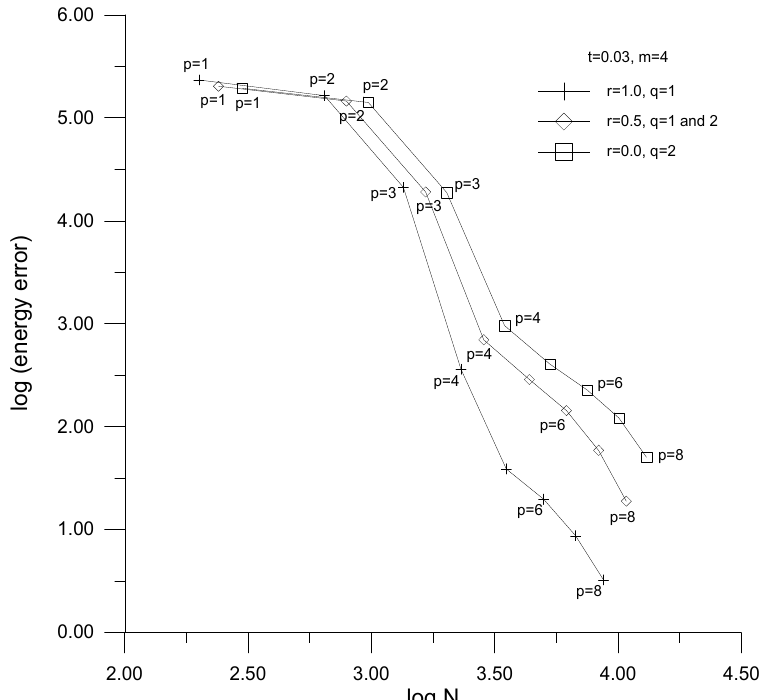
Figure 25. Convergence curves—the bending-dominated shell with the enhanced transition elements.